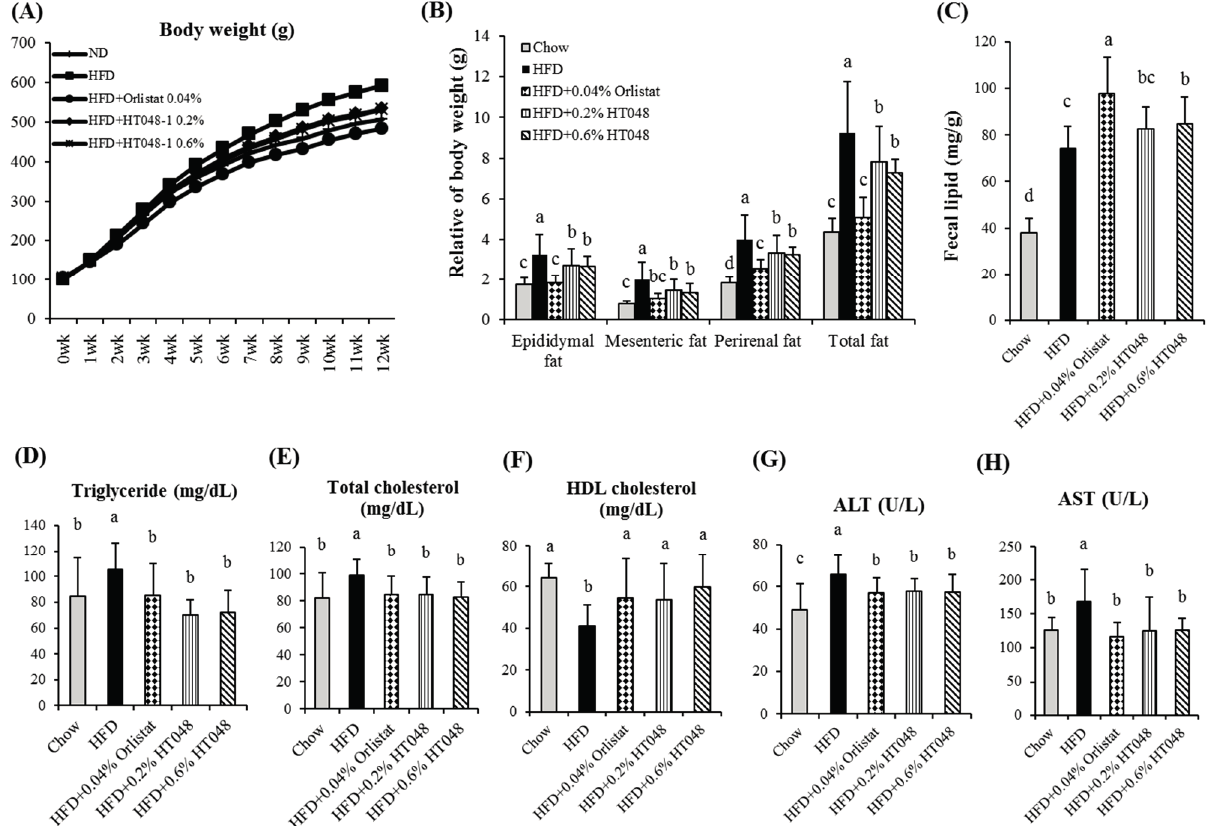
Figure 3. Effect of HT048 on body weight ( A ), WAT ( B ) weights, fecal lipid content ( C ) and serum parameters ( D – H ) in HFD-induced obese rats. Values are presented as the mean ± S.D. ( n = 12). abc Means not sharing common letters are significantly different among the groups at p <